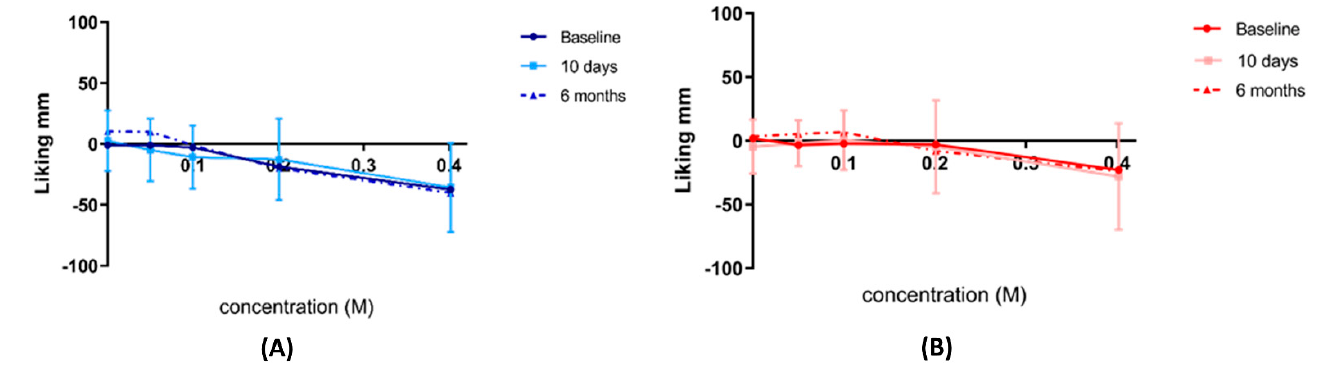
Figure 6. Hedonic general Labeled Magnitude Scale ratings of sweet taste. Consummatory reward value of sweet taste assessed by the Hedonic general Labeled Magnitude Scale for ( A ) control n = 19 (blue) and ( B ) Endobarrier n = 24 (red) groups. Data are presented as the mean rating at each concentration ± SD.